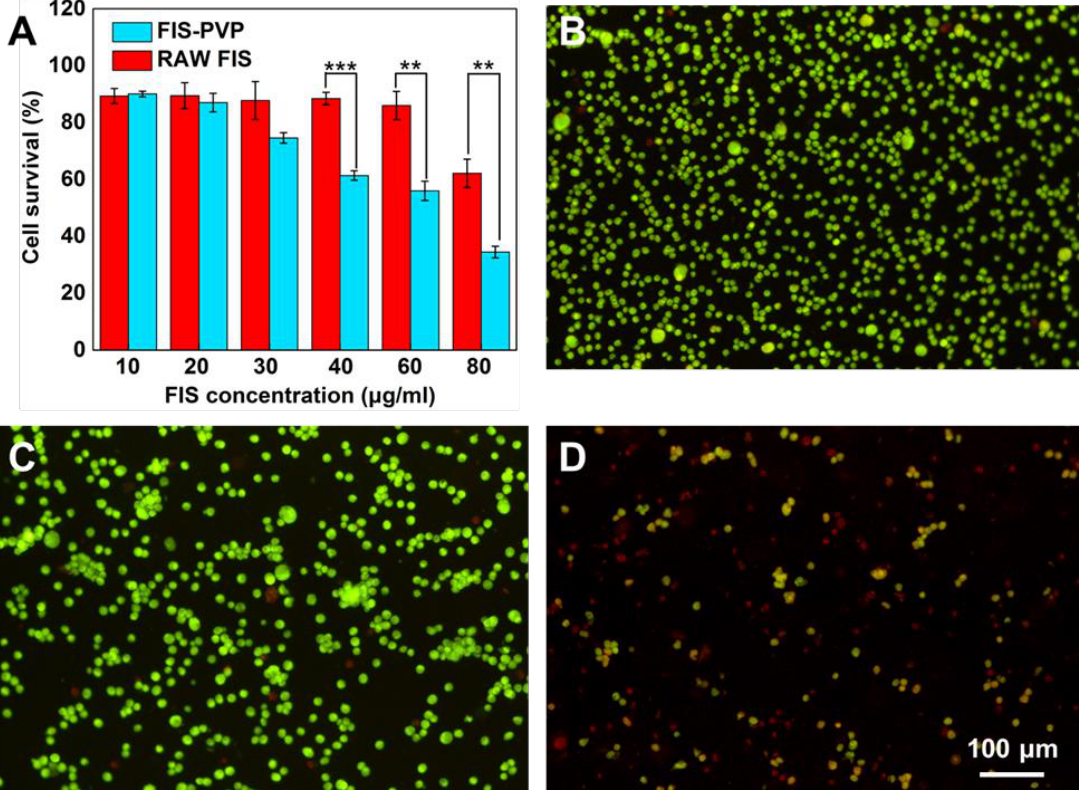
Figure 7. In vitro cytotoxicity study of FIS-PVP NPs. ( A ) Relative viability of MDA-MB-231 after treatment with FIS-PVP NPs and raw FIS. Fluorescence images of MDA-MB-231 cell staining with AO/EB after various treatments (the live cells are green, and the dead cells are red). ( B ) Negative control (media), ( C ) raw FIS, and ( D ) the FIS-PVP NPs.